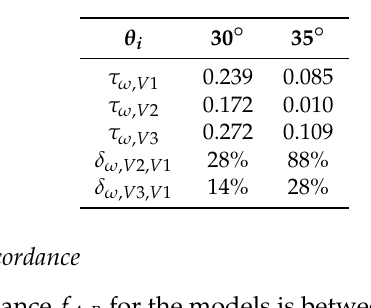
Table 3. Biconical transmission for measurements τ ω , V 1 and simulation results τ ω , V 2 and τ ω , V 3 .